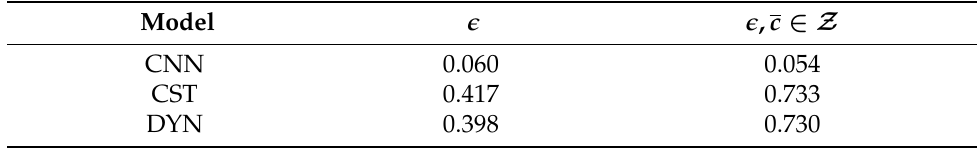
Figure 7. Hexbin plots of model predictions against ground truth conditioned on c ( c ) DYN model. Table 3. HIT test set error values for c (cid:48) 2